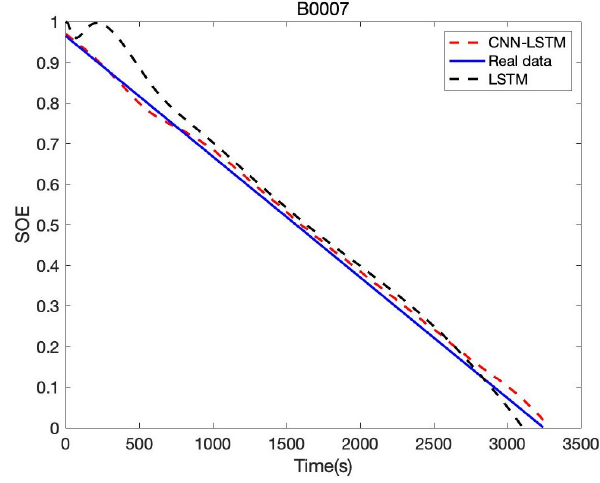
Figure 21. Battery SOE prediction result of B0007.